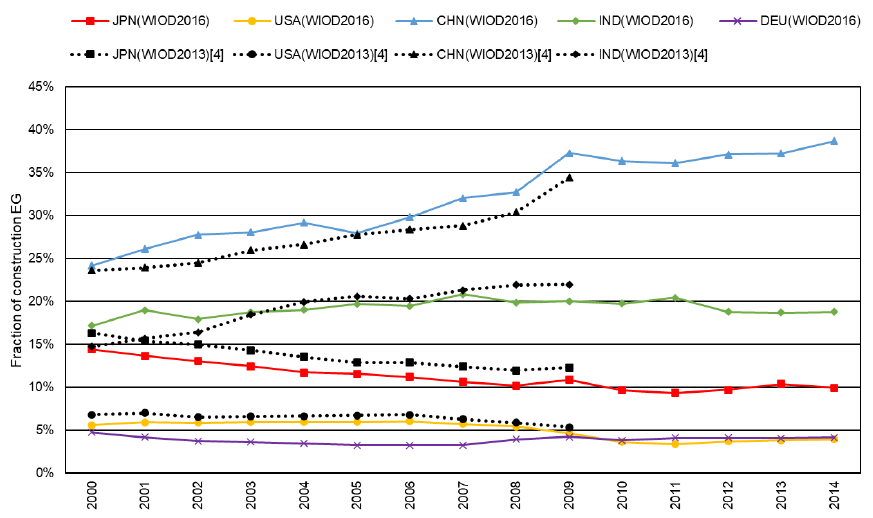
Figure 10. Annual variations in fraction of construction EGs. The fraction of construction EG of WIOD (2013) is cited from Reference [4].